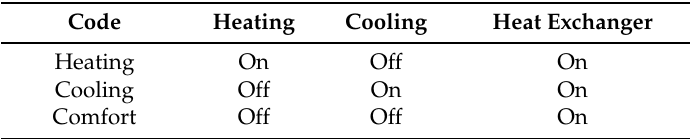
Table 1. Configurations. Table 1.